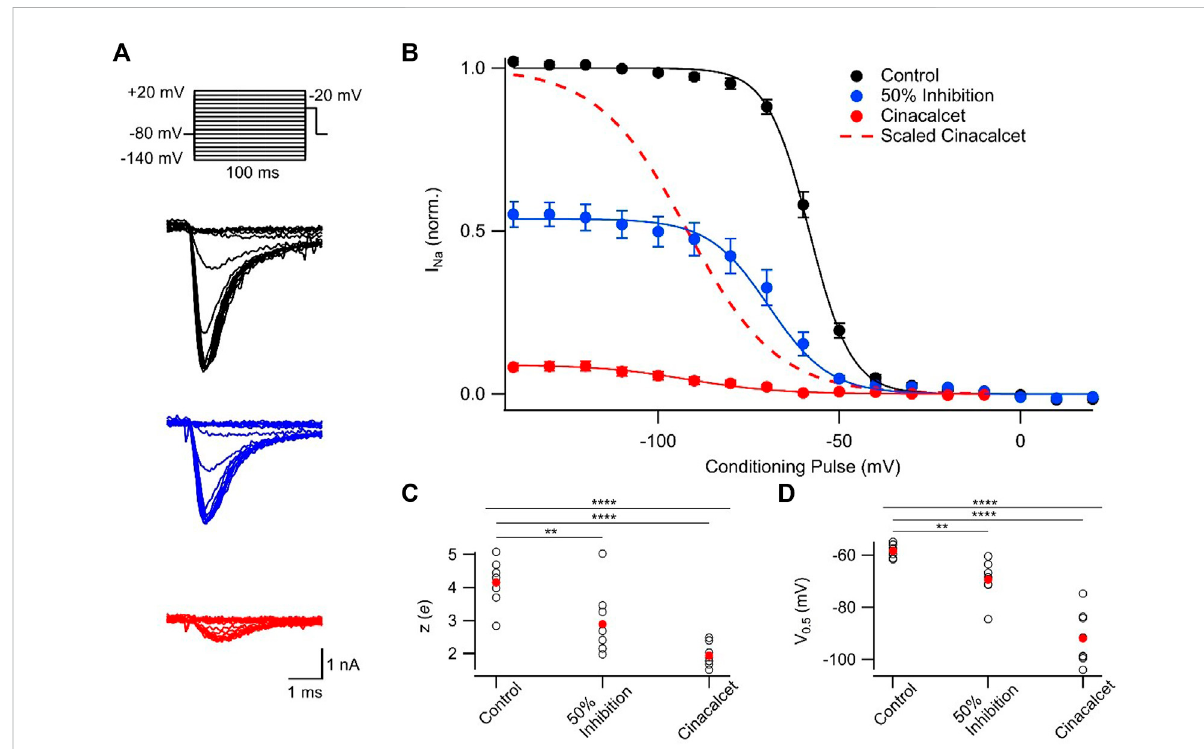
FIGURE 2 Cinacalcet shifted the voltage-dependence of fast inactivation. (A) Representative traces from a protocol used to isolate and evaluate the voltage-dependence of fast inactivation. Measurements were taken by applying a 100 ms depolarization to varying voltages ( − 140 to +20 mV in 10 mVincrements)fromaholdingpotentialof − 80mV,anddeliveringatestpulseto − 20 mVincontrolconditions(black),followinginhibitionofhalf ofthestartingcurrentby5 µMcinacalcet(blue),andfollowingfullinhibition(red). (B) PlotofaveragenormalizedpeakVGSCcurrentselicitedby test pulse following 100 ms conditioning pulse in control (black; n = 8), following inhibition of half of the starting current by cinacalcet (blue; n = 8), and following full inhibition (red; n = 8) fi t to the Boltzmann equation. The 50% inhibition data were collected once cinacalcet had decreased the VGSC current elicited by the step from − 80 mV to − 20 mV, to 50% of control. Dashed red line indicates average cinacalcet fi t normalized to the average control maximum. (C) Plot of individual (black, open circles) and mean (red, fi lled circles) apparent valence values. 1-W ANOVA RM test returned p < 0.0001 overall, with p = 0.0078 and < 0.0001 for control vs. 50% or control vs. full block respectively by Holm-Sidak correctedmultiple comparisons. (D) Plotofindividual(black,opencircles)andmean(red, fi lledcircles)V 0.5 values.1-WANOVARMtestreturned p < 0.0001overall,with p = 0.003 and < 0.0001 for control vs. 50% or control vs. full block respectively by Holm-Sidak corrected multiple